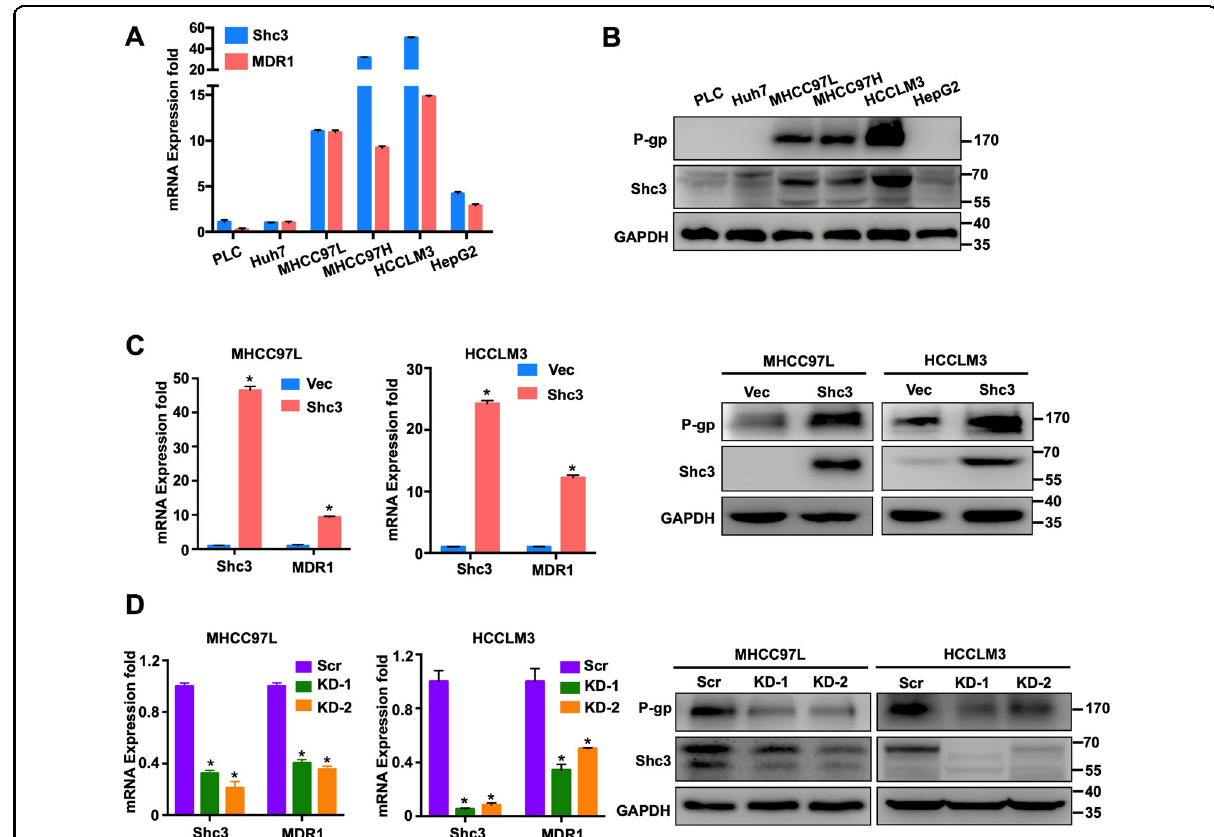
Fig. 2 Identi fi cation of Shc3 as a positive regulator of MDR1/P-gp expression. A The mRNA levels of Shc3 and MDR1 in six liver cancer cell lines were analyzed by qRT-PCR. B Shc3 and P-gp protein expression in six liver cancer cell lines. C Overexpression of Shc3 resulted in increased expression of MDR1 in MHCC97L and MHCCLM3 cells. (left) Relative mRNA expression of Shc3 and MDR1 were examined by qRT-PCR; (right) Relative protein expression levels of Shc3 and P-gp were detected by Western blotting. D Knockdown of Shc3 reduced the expression of MDR1 in MHCC97L and MHCCLM3 cells. Shc3 expression was knocked down by short hairpin RNAs. Data represent the mean ± SD (* P < 0.05 vs. control, by one-way ANOVA or Student ’ s t